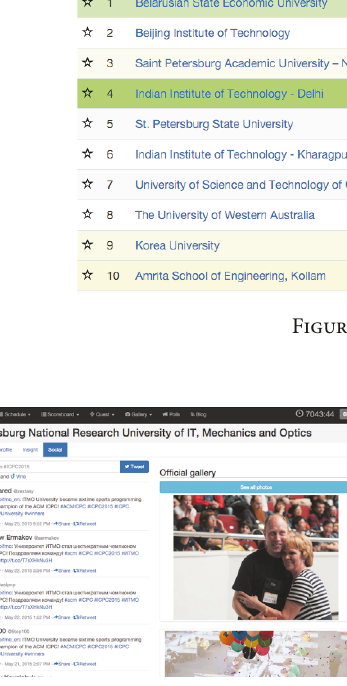
Figure 16: Scorebar.